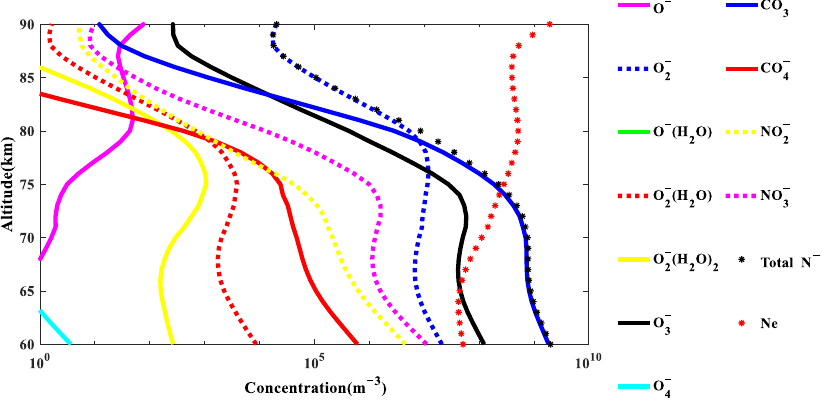
Figure 4. Distribution of negative ions, total negative ions, and electrons at 12:00 LT.